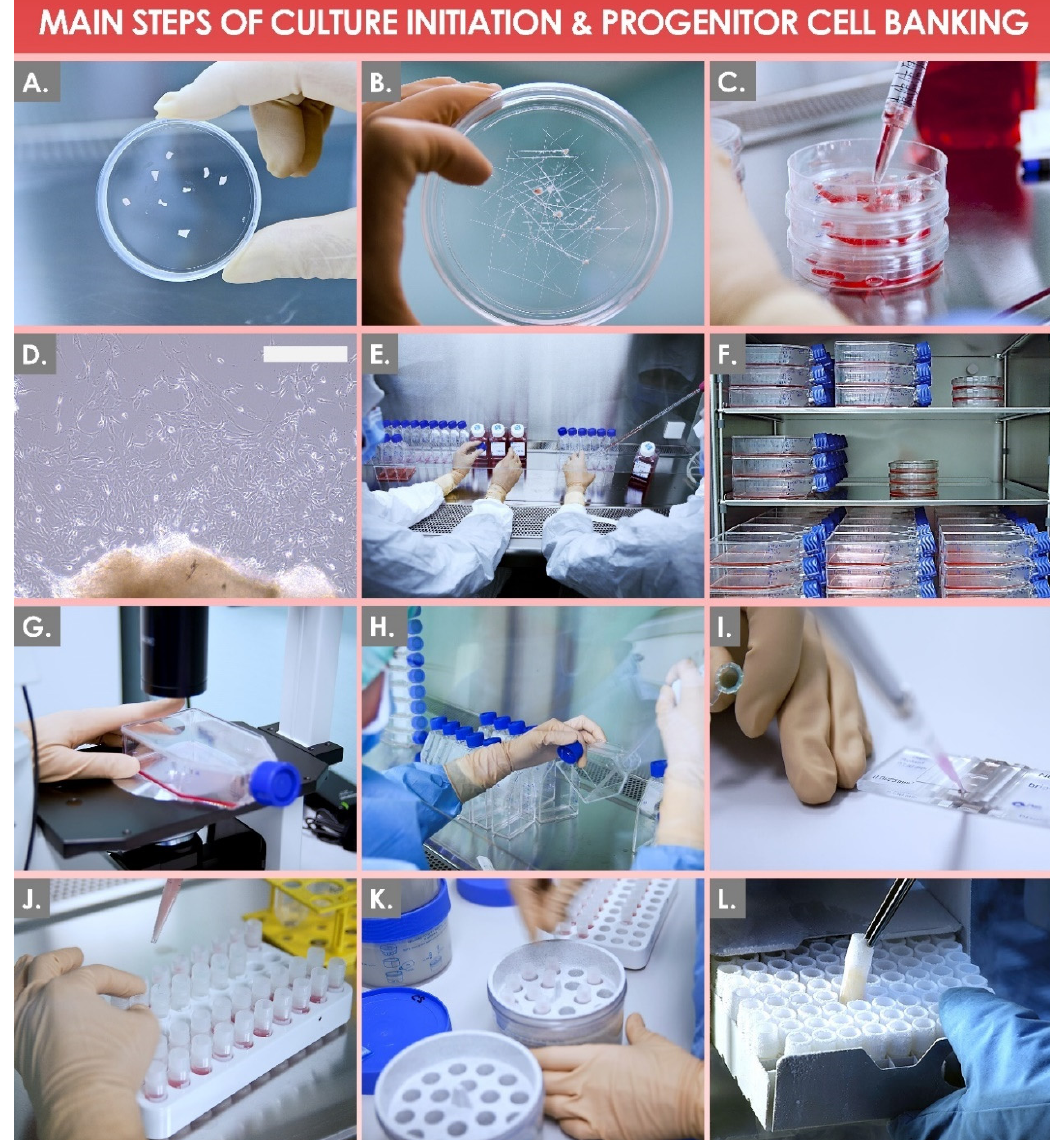
Figure 2. Illustrative overview of the main technical phases and steps required for the culture initiation of primary progenitor cells and for cell stabilization in a tiered cell-bank system. ( A ) Tis- sue procurement following the organ donation. ( B ) Mechanical tissue treatment in the primary culture vessel. ( C ) Proliferation medium dispensing for the promotion of preliminary cell growth. ( D ) Primary in vitro cell outgrowth in adherent monolayer. Scale bar = 75 µ m. ( E )